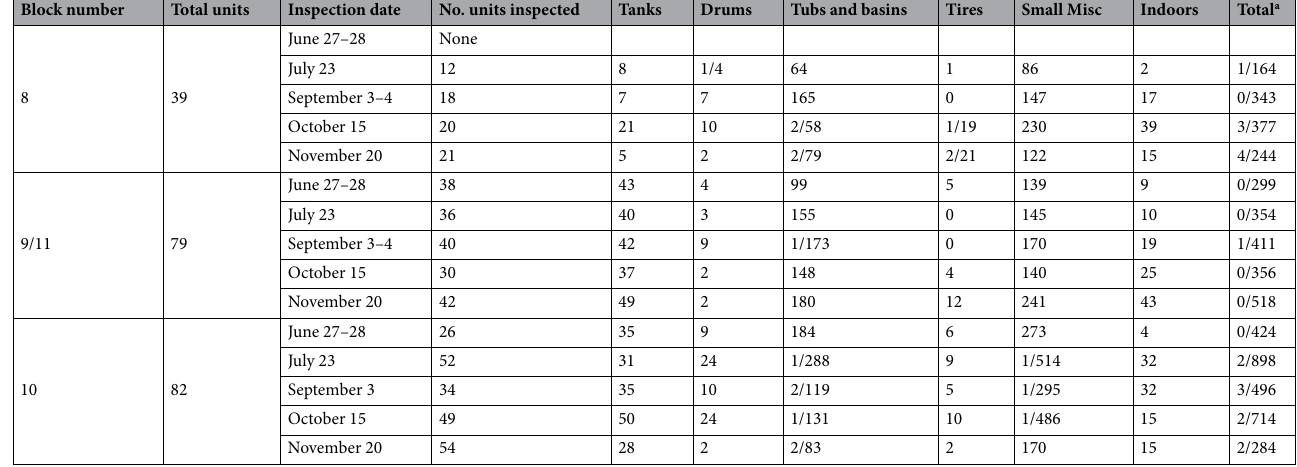
Table 2. Potential water containers and type for Vector blocks in Curepe, Trinidad, 2019. a No. Positive containers/Total containers